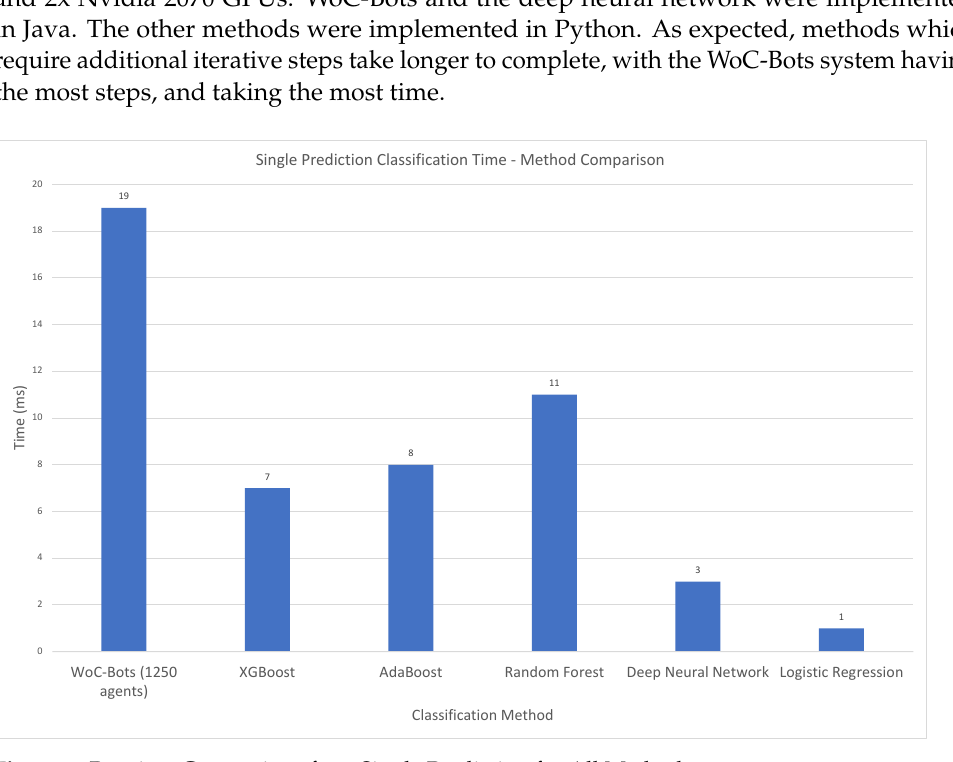
Figure 3. Runtime Comparison for a Single Prediction for All